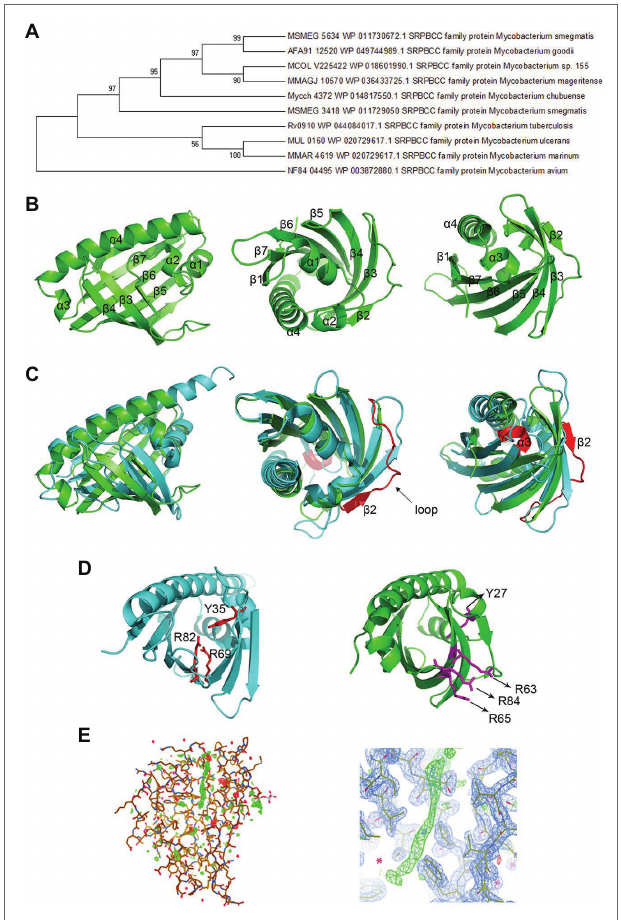
FIGURE 2 | Structure of the MSMEG_5634 protein. (A) The evolutionary tree of the MSMEG_5634 protein. NCBI PSI-BLAST (Position-Specific Iterated BLAST) and KEGG BLAST were performed to search for homologs of MSMEG_5634. The evolutionary tree was constructed through MAGE 7.0. Larger taxonomic clusters have been collapsed for clarity. (B) The overall structure of MSMEG_5634. (C) The structural superimposition of MSMEG_5634 (green) and TcmN ARO/CYC (cyan) performed using PyMOL. The major differences between MSMEG_5634 and TcmN ARO/CYC are colored red. (D) The catalytic center of TcmN (cyan) and the corresponding sites in MSMEG_5634 (green). The cyclization or aromatization of polyketides is mediated by Tyr-35, Arg-69, and Arg-82 in TcmN ARO/CYC. The corresponding residues in MSMEG_5634 (green) are Tyr-27, Arg-63, Arg-65, and Arg-84. (E) The 2Fo-Fc electron density map of MSMEG_5634 contoured at 1 sigma level. A linear electron density was detected inserting into the hydrophobic pocket of